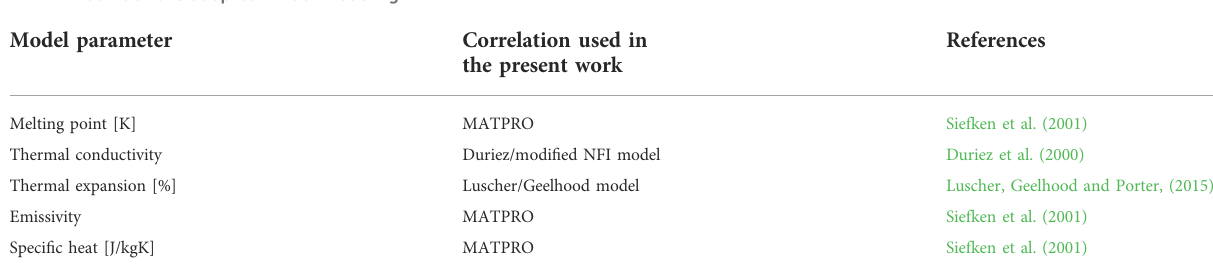
TABLE 2 Correlations adopted in fuel modeling.